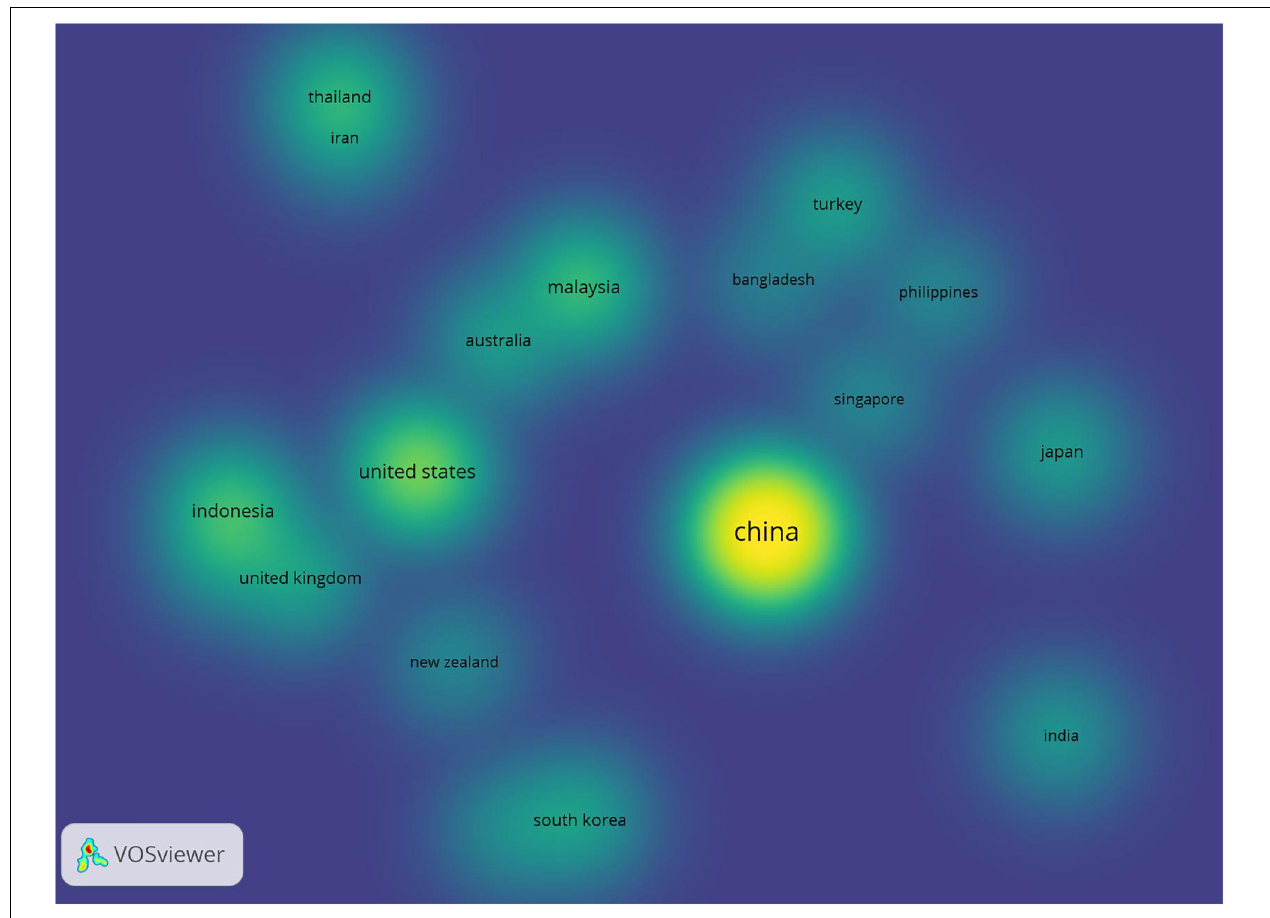
FIGURE 3 | Density map of the top 10